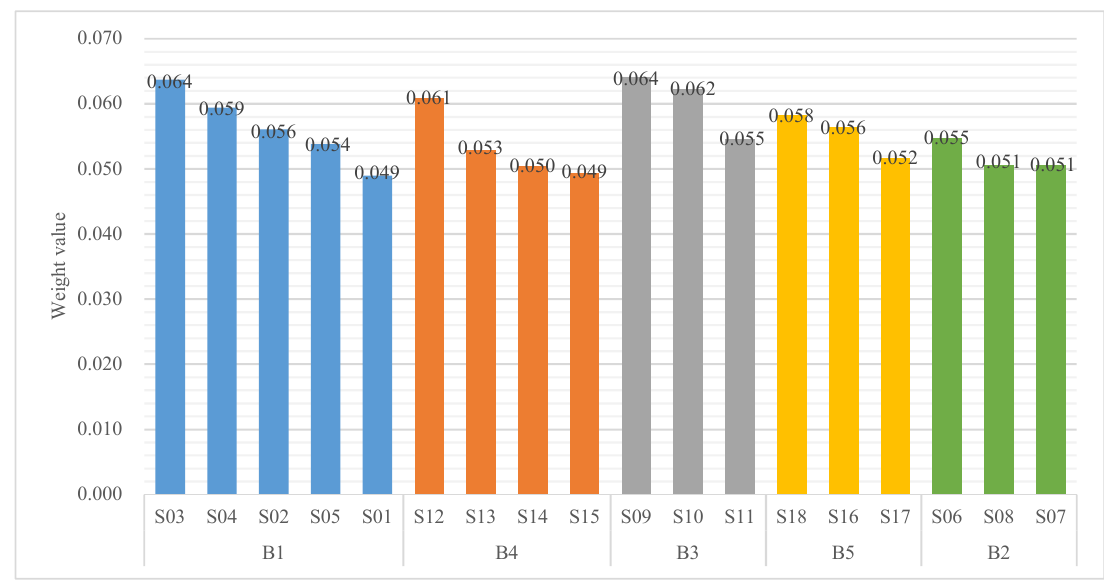
Figure 3. The weight value of the 18 evaluation indexes.